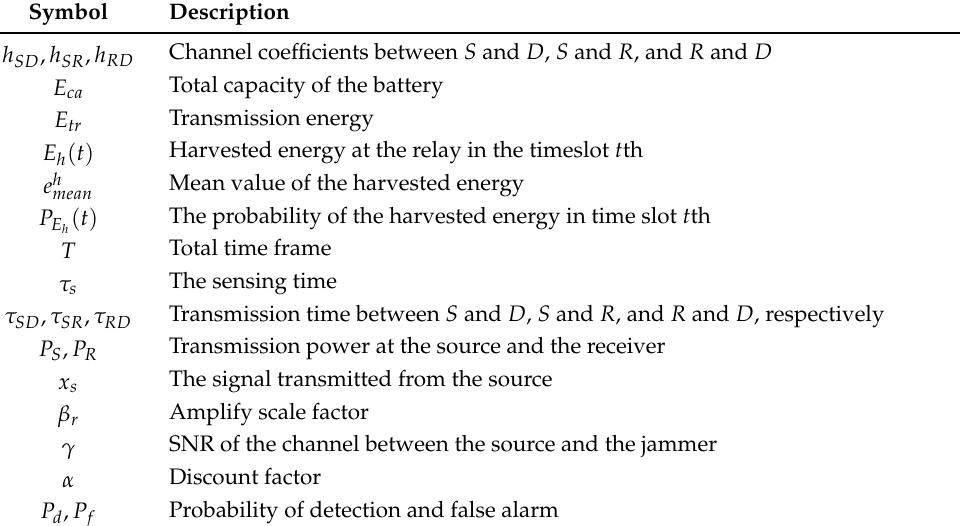
Table 1. The notation list.